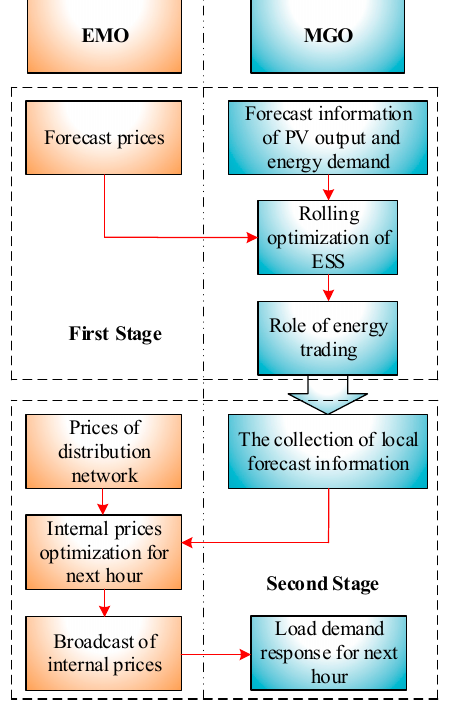
Figure 2. Operation strategy of an MMG (EMO: Energy Market Operator, MGO: Microgrid Operator, PV: photovoltaic).